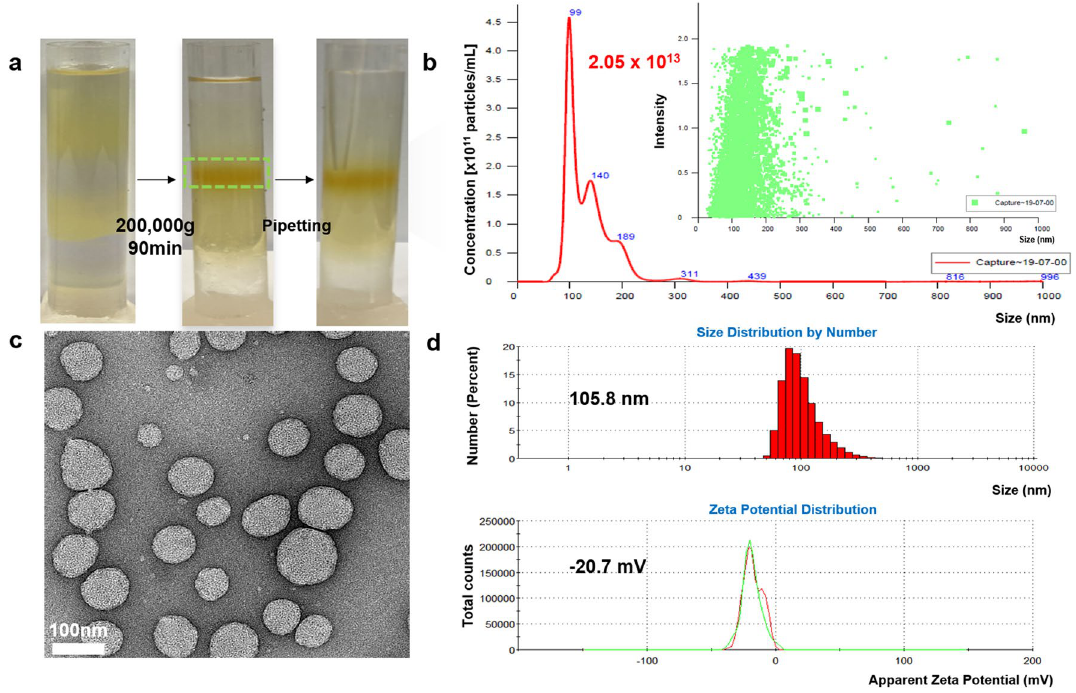
mission electron microscopy image of GDEs. d dynamic light scat- tering analysis results showing the size and zeta potential of